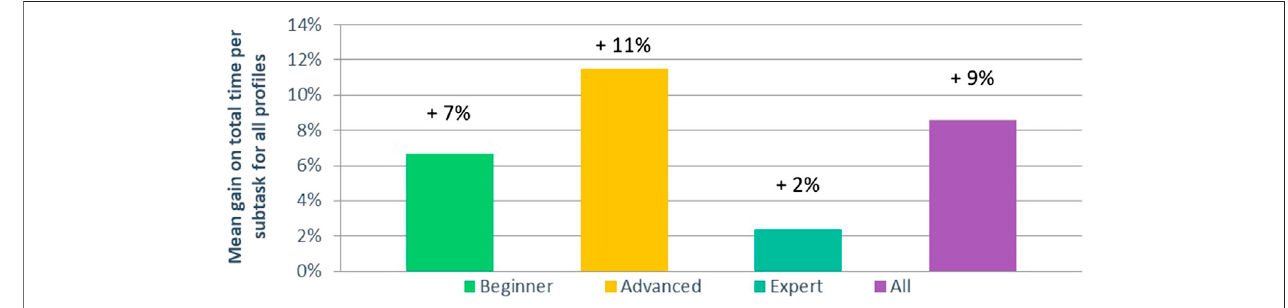
FIGURE 9 | Mean gain on total time per sub-tasks for all pro fi les of users.